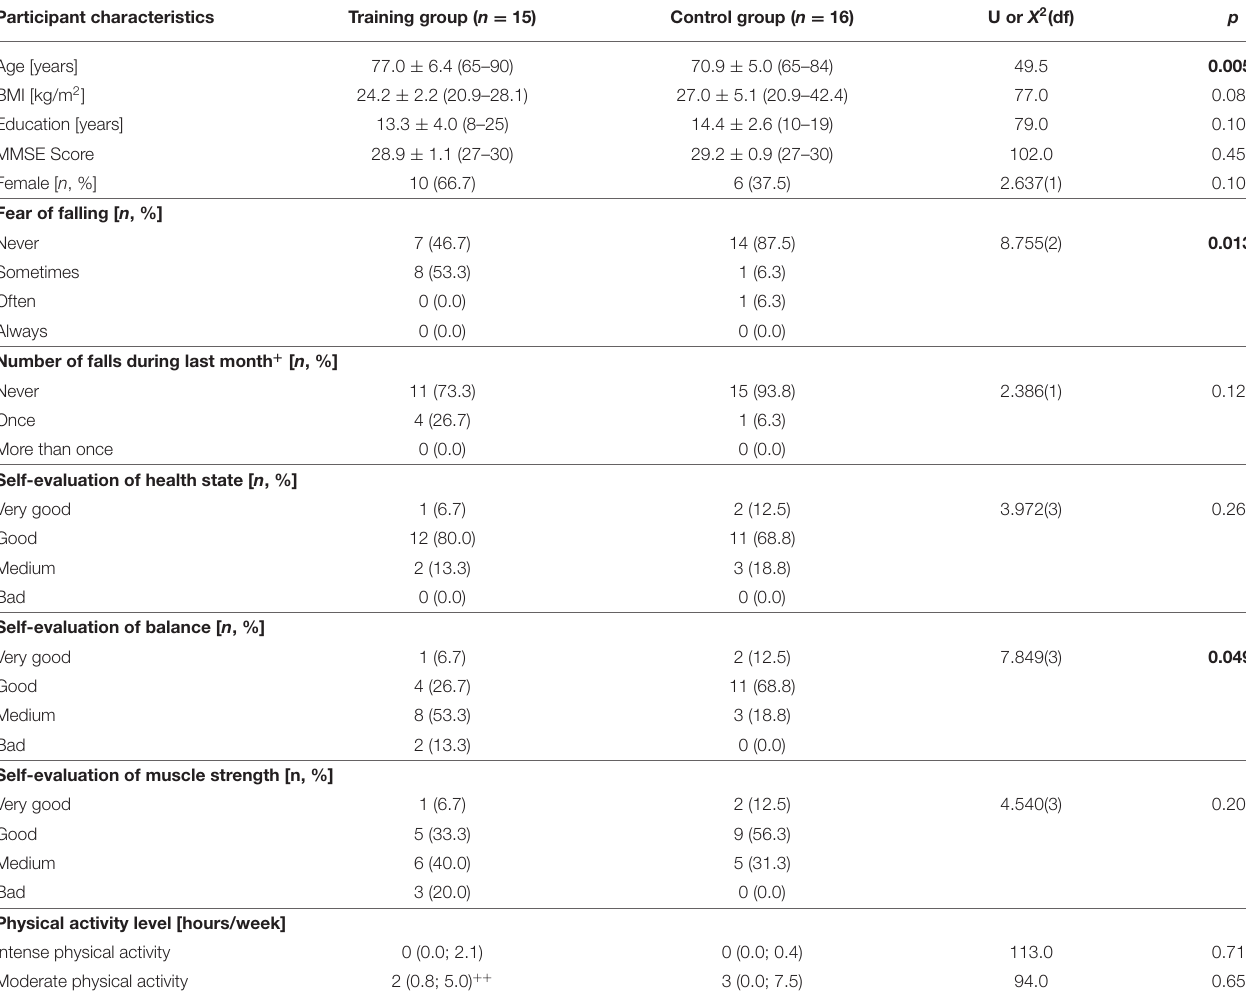
TABLE 1 | Baseline demographic characteristics and screening values of analyzed participants. Participant